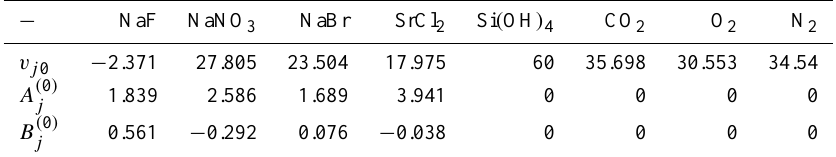
Table 4. Parameters from Eq. (14) for apparent molal volumes (cm 3 mol − 1 ) of binary electrolytes at 25 ◦ C. These equations are in terms of ionic stength I 0 . Sources are NaF, NaNO 3 , NaBr, SrCl 2 – Millero et al. (1977), Si ( OH ) 4 – Duedall et al. (1976), CO 2 , O 2 , N 2 – Watanabe and Iizuka